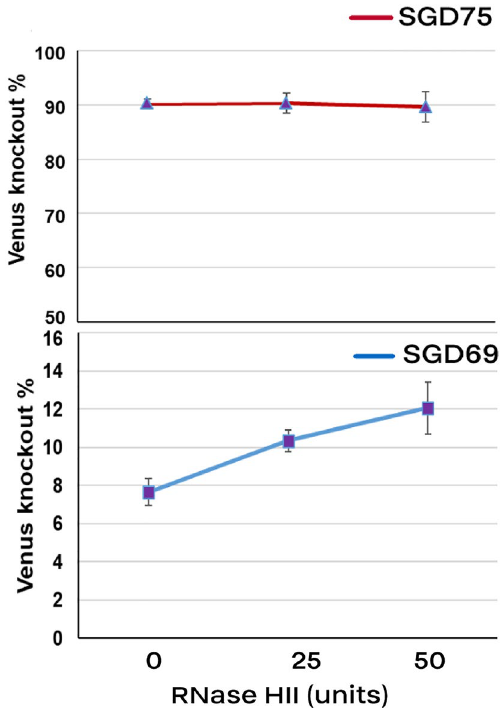
Figure 6. Effect of RNase HII on the HDR rate. MEF cells were electrotransfected with pSGD plasmids carrying both the CRISPR system and DNA donor. We included different concentration of RNase HII into the electroporation media. The pSGD75 plasmid caused both NHEJ- and HDR-induced Venus